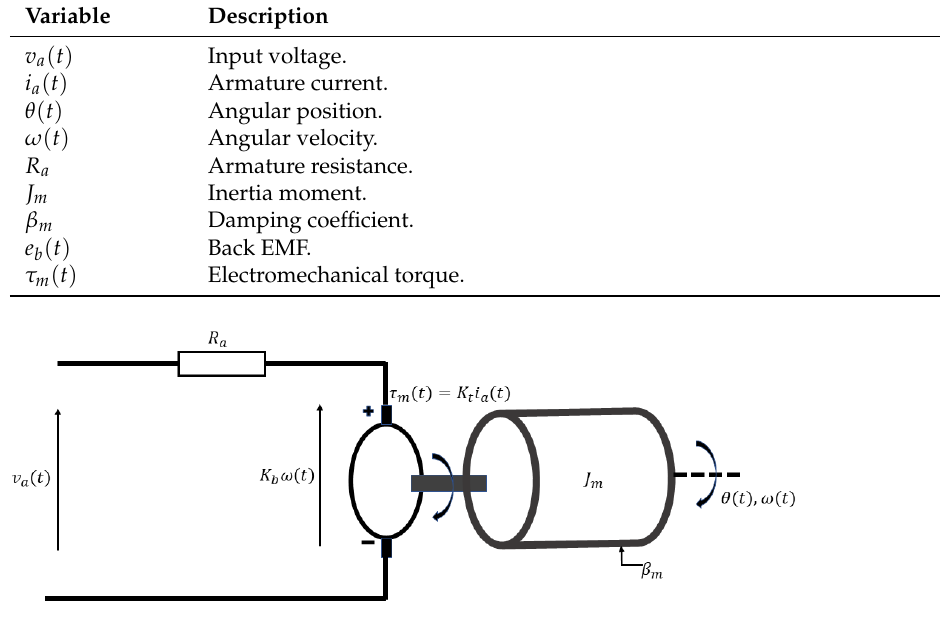
Table 4. Interpretation of the variables presented in Figure 2.